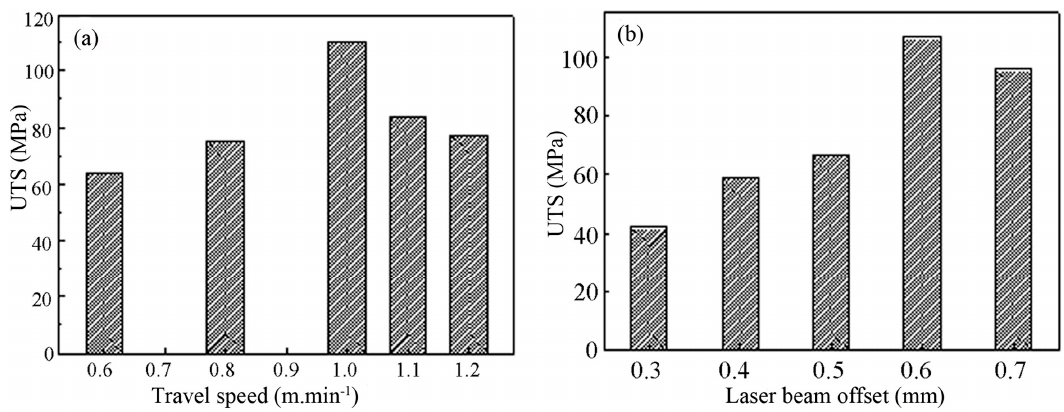
Figure 13. Effect of laser-welding parameters on the ultimate tensile strength (UTS) of the Al/steel butt joints: ( a ) travel speeds; ( b ) laser beam offsets.